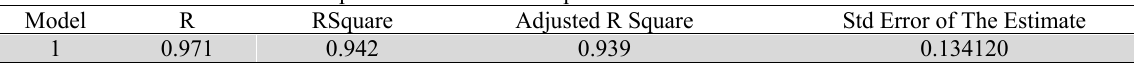
Determinant of the Influence of Independent Variable on Dependent Variable